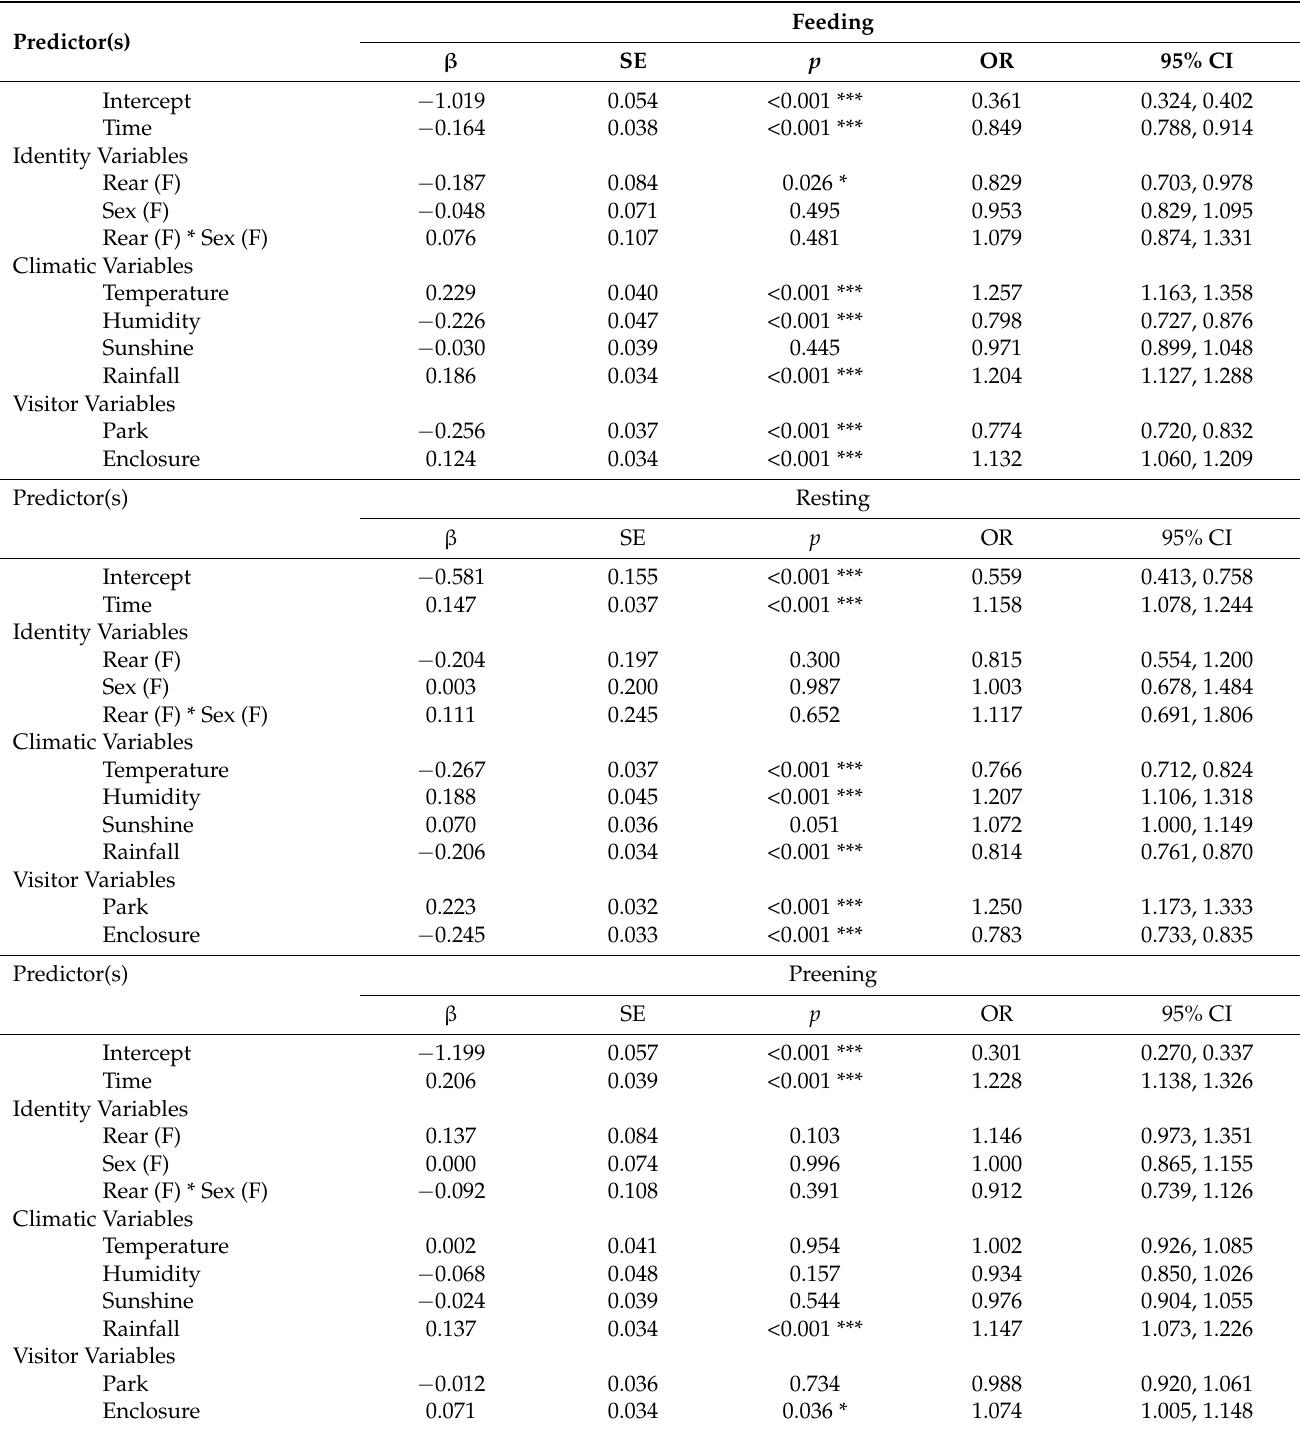
Table A2. Full conditional binomial GLMMs investigating the influence of predictors on the performance of key state behaviours in